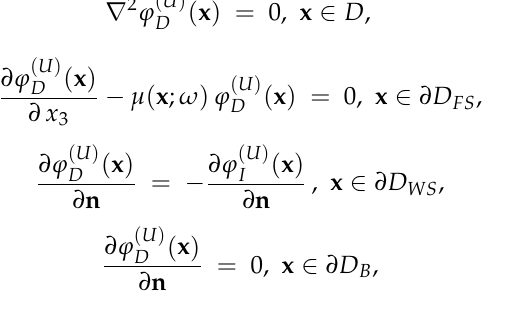
Figure 5. ( a ) Color plot and ( b ) rendered view of the free surface elevation generated by the steady per-